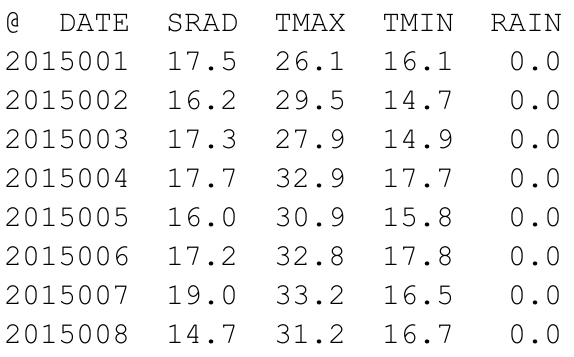
Figure 3. Example of WTH, WTD and WTDE daily weather file, DATE format is YYYYDOY, (DOY is Day of year), SRAD = Solar exposure in MJ/m 2 -day, TMAX, TMIN are maximum and minimum temperature in Celsius, and RAIN is precipitation in mm.